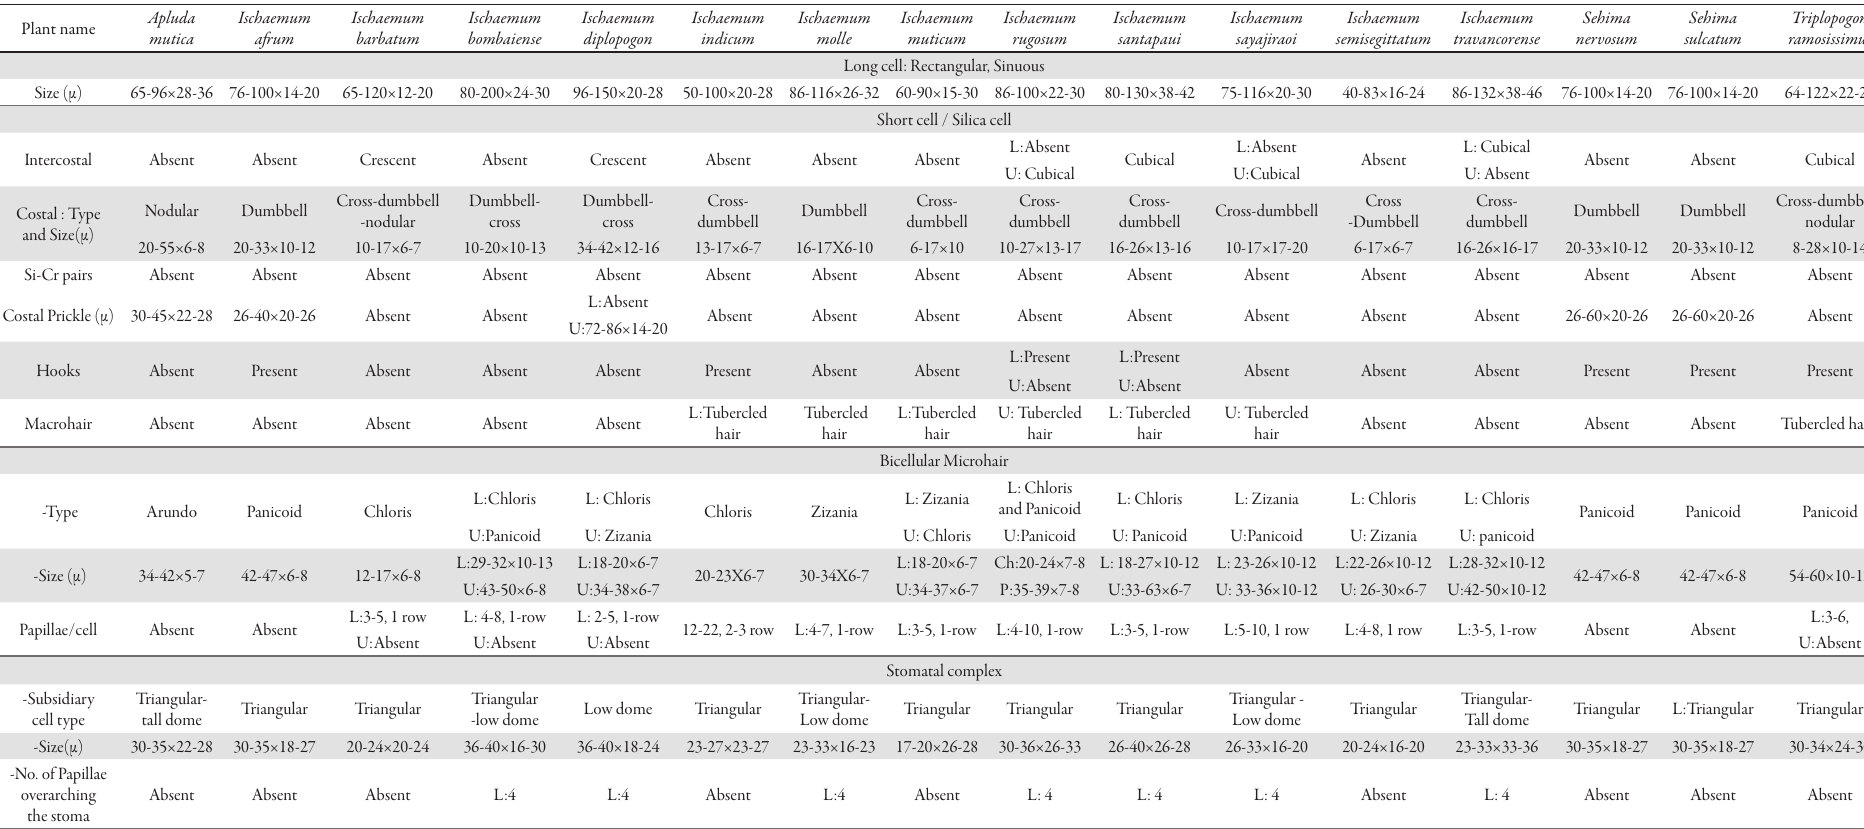
Tab. 1. Comparison of studied qualitative and quantitative micromorphological characters in the tribe Ischaemineae (L: lower/abaxial epidermis, U: upper/adaxial epidermis, Ch: Chloris type, P: Panicoid